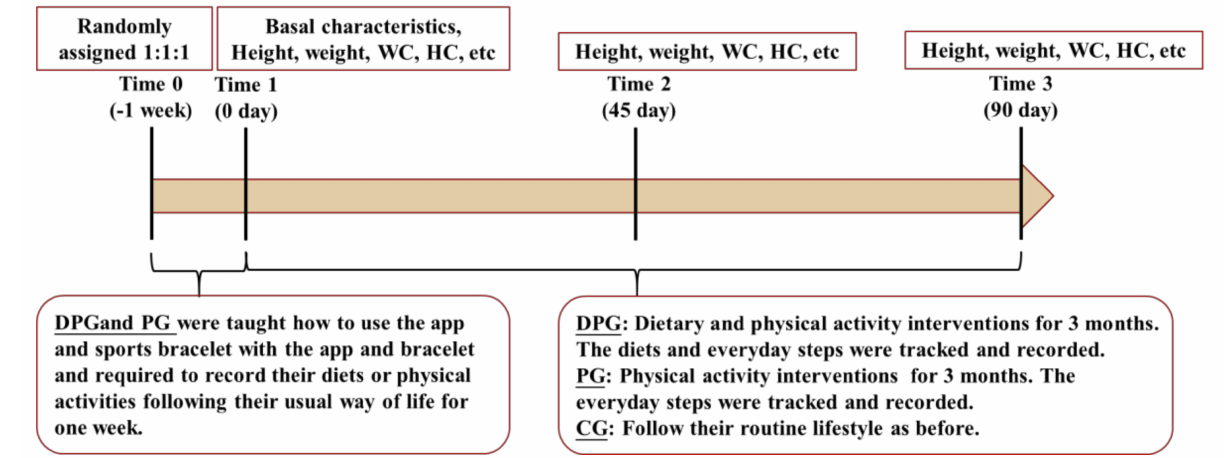
Figure 2. Flow diagram of the